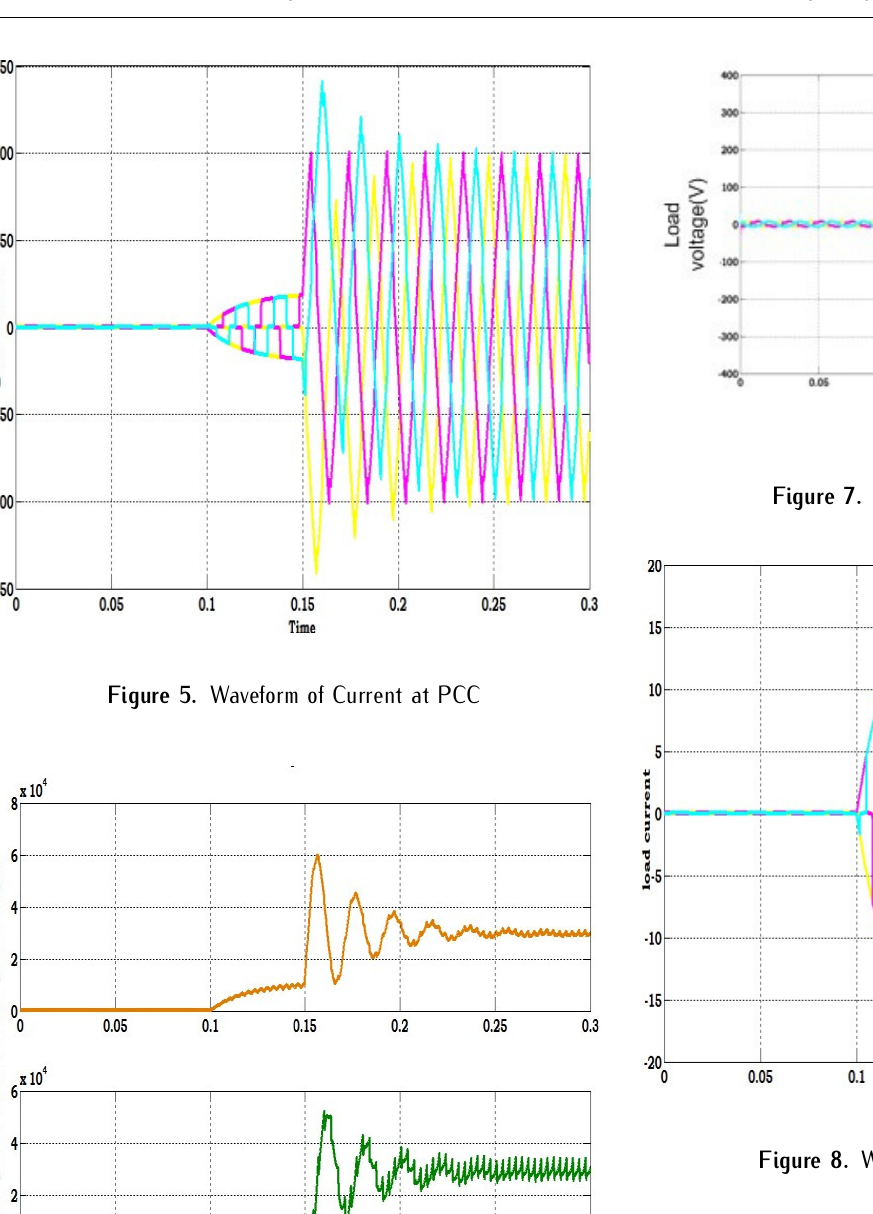
at 3000W, 3000VAR injecting the active power, reactive power.